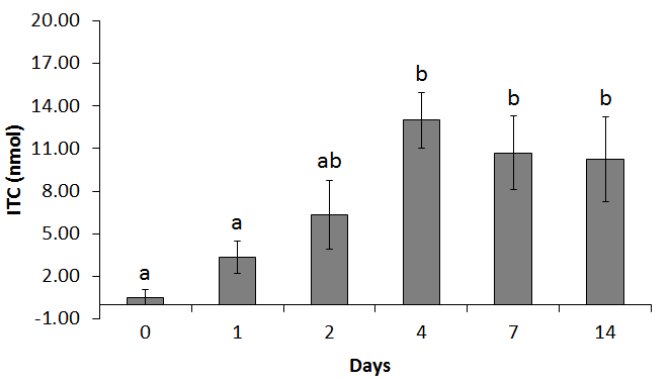
Figure 2. Rats ( n = 6) were fed 10% cooked broccoli diet for 0–14 days. Concentrations of total isothiocyanate (ITC) in rat cecal supernatant after incubating ex vivo with GRP for 120 min. Values with similar letters are not different ( p <